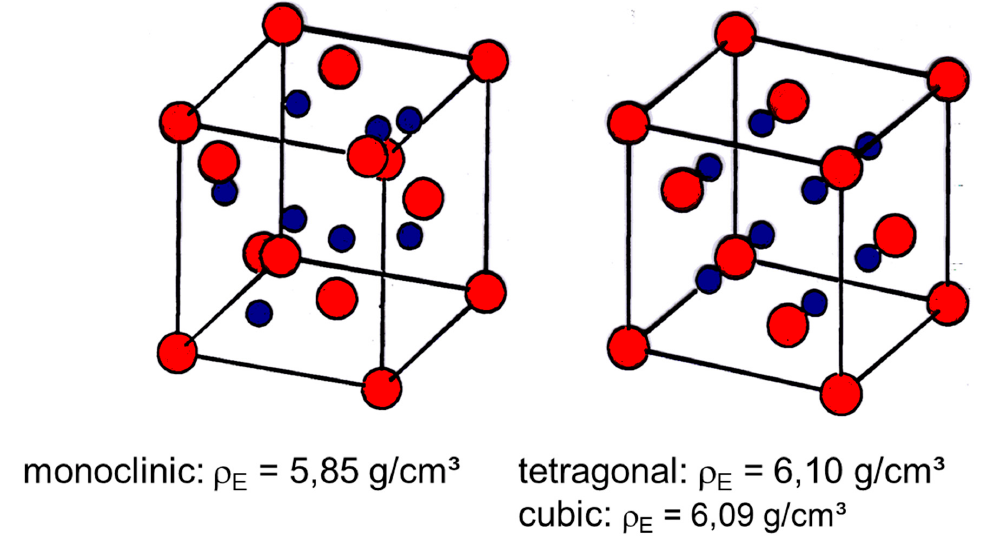
Figure 5. Orientation of the Zr-ions in the monoclinic and tetragonal lattice.